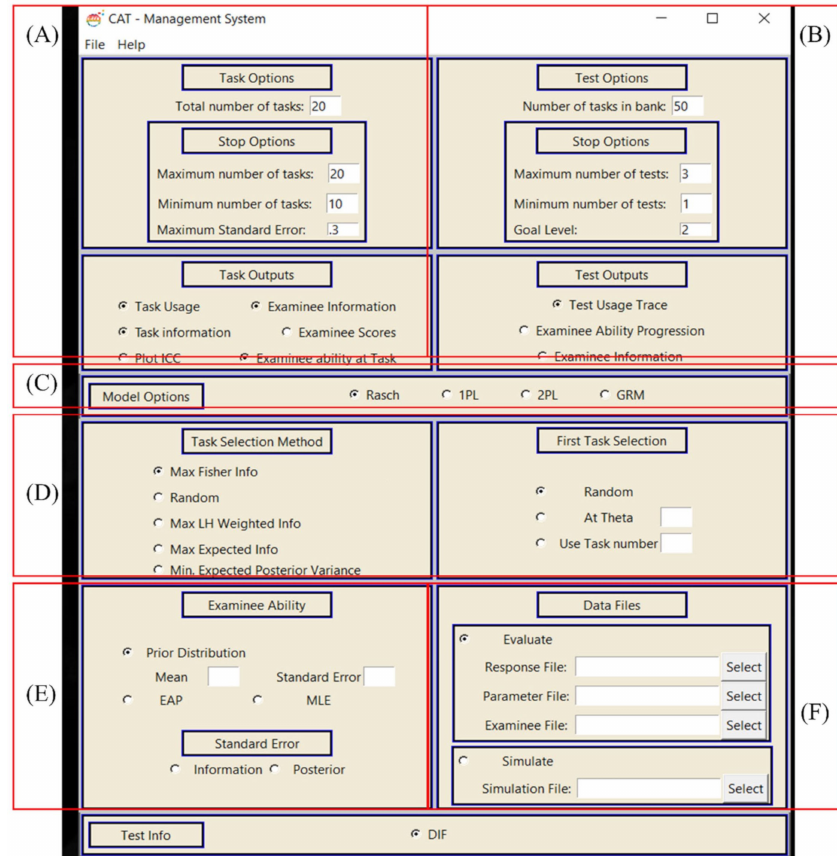
Figure 3. An example of CAFT using the CAT system: Engine Window. ( A ): options related to general item information; ( B ): options related to the general test information; ( C ): options related to the IRT models; ( D ): core part of the adaptive system; ( E ): the examinee’s ability estimation area; ( F ): area for selecting data files or conducting a